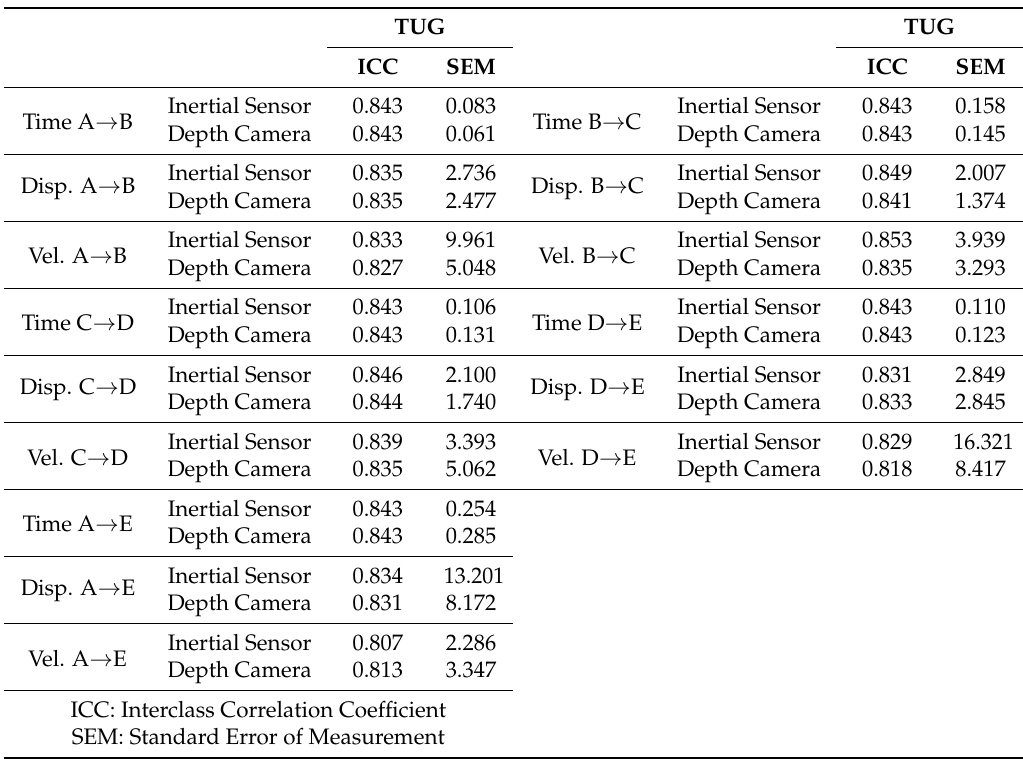
Table 2. Reliability of the measure for the TUG